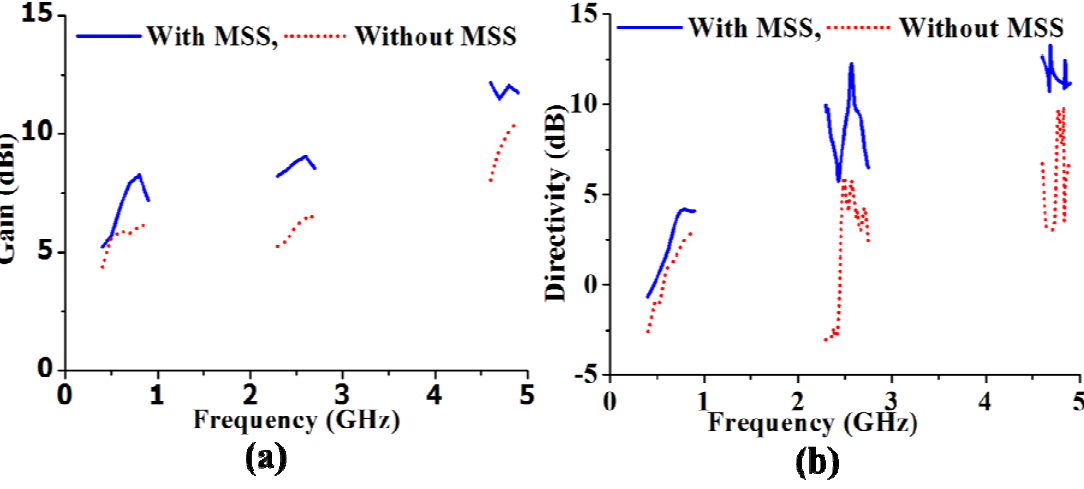
Figure 6. Measured ( a ) gain; and ( b ) directivity of the antenna with and without MSS.